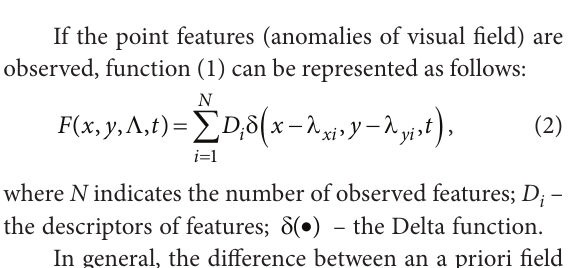
Fig. 1. Function of surface field and its